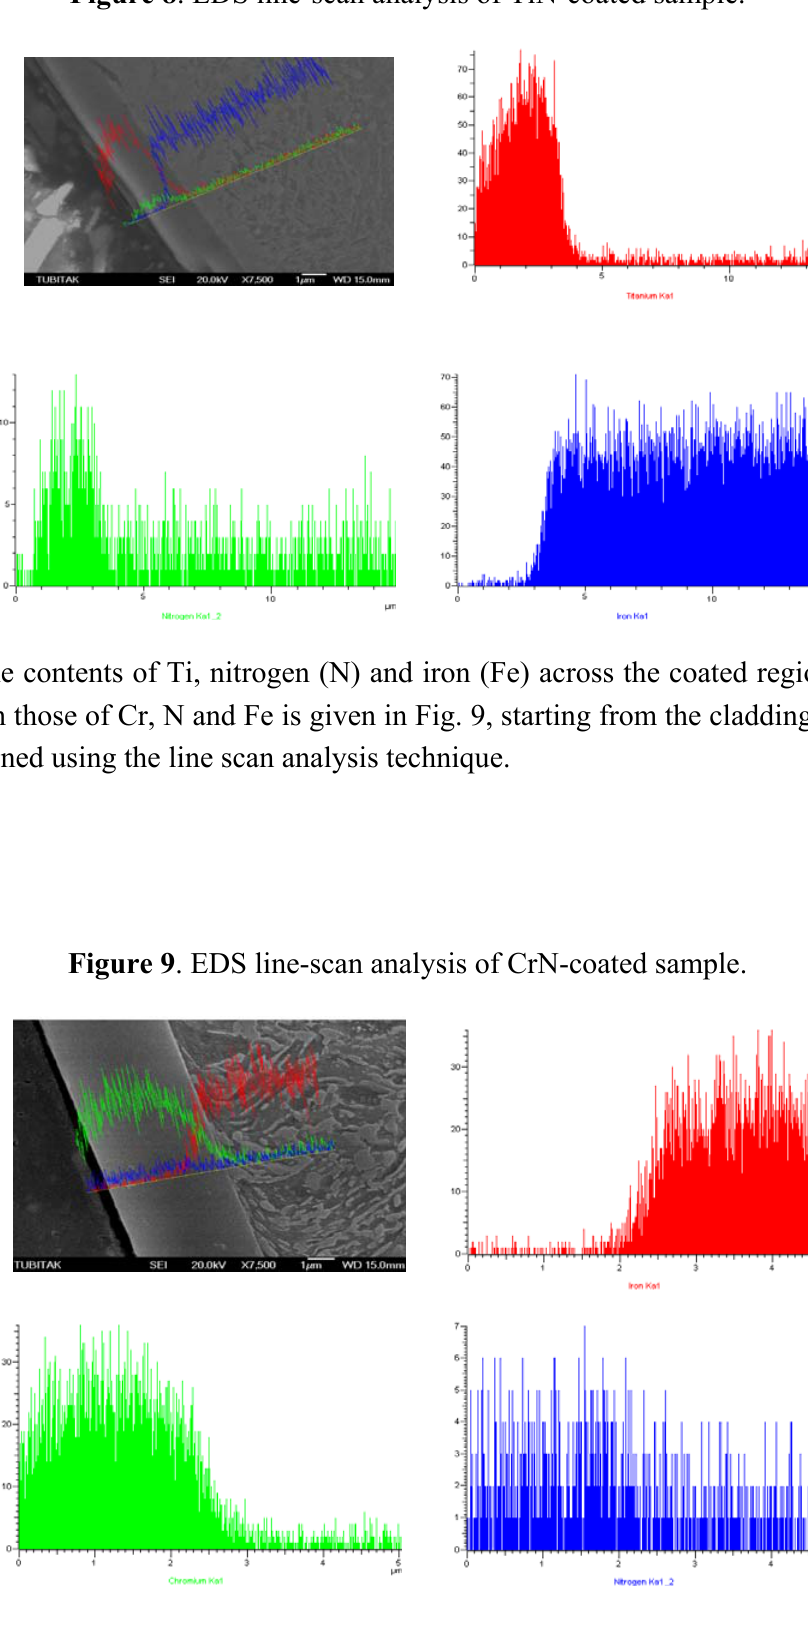
Figure 8 . EDS line-scan analysis of TiN-coated sample.